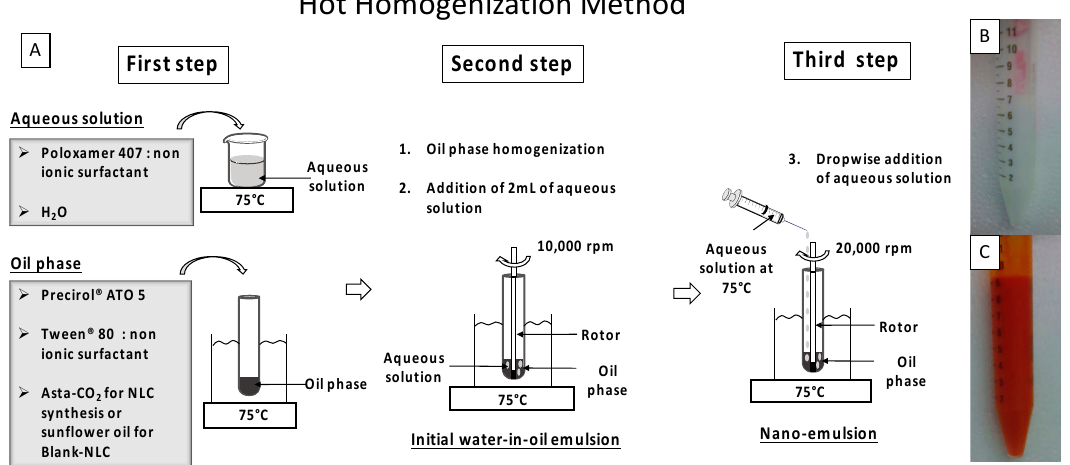
Figure 1. Scheme of synthesis procedure ( A ); macroscopic images of Blank-nanostructured lipid carrier (NLC) ( B ) and AstaCO 2 -NLC ( C ).